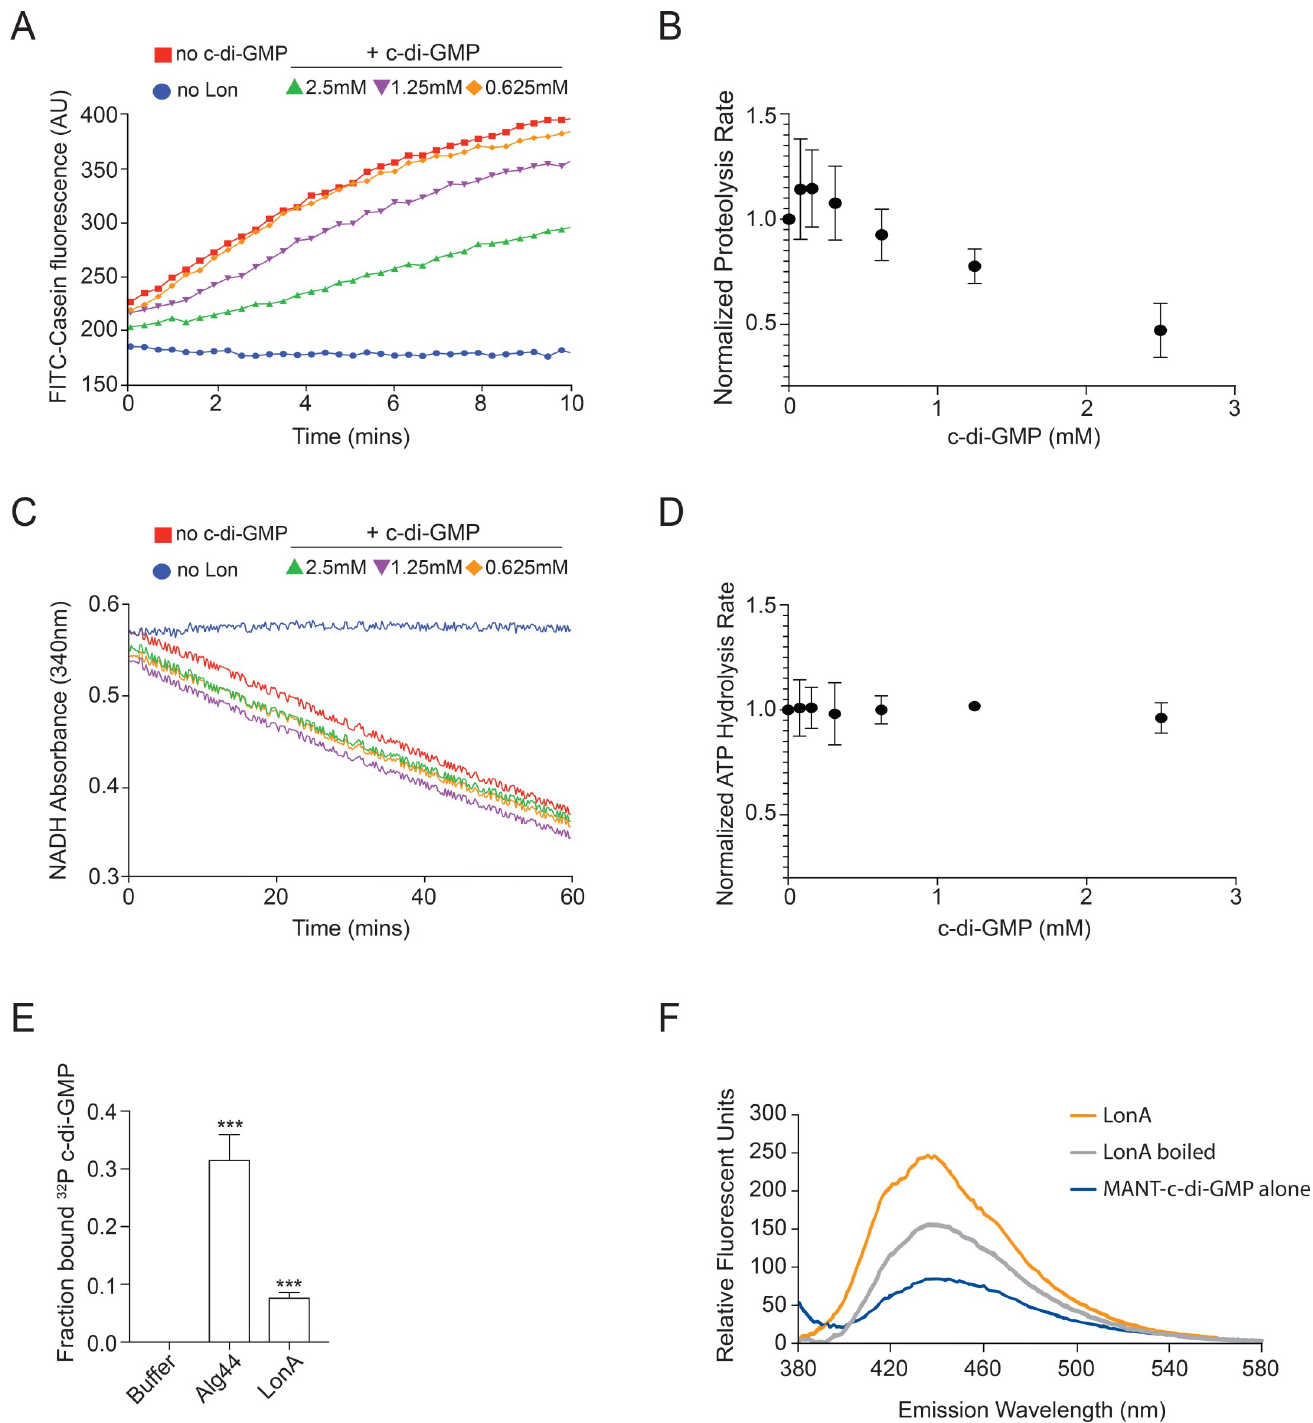
Fig 6. LonA proteolysis is directly regulated by c-di-GMP. In vitro proteolysis and protein ligand binding assays are shown. (A) Proteolysis of FITC-casein by purified LonA results in increased fluorescent signal. (B) Initial rate of substrate degradation as a function of c-di-GMP. (C) ATP hydrolysis for LonA alone and in the presence of c-di-GMP was monitored by loss of NADH, which is consumed stoichiometrically with ATP. (D) Rate of ATP hydrolysis as a function of c-di-GMP. Representative curves for (A) and (C) are shown with different concentrations of c-di-GMP. (E) Quantification of fraction bound of 32 P-c-di-GMP to LonA by DRaCALA. Binding data shown represent the average and SD of triplicate independent experiments. Fraction bound by LonA and Alg44 were compared to buffer control by Student’s t-test. ��� indicate p value of 0.0005, respectively. (F) Purified LonA or heat denatured Lon (boiled) were incubated with MANT-c-di-GMP. Representative emission fluorescence spectrum (excitation at 355 nm) is shown. Emission spectrum of MANT-c-di-GMP alone is also shown as a control.